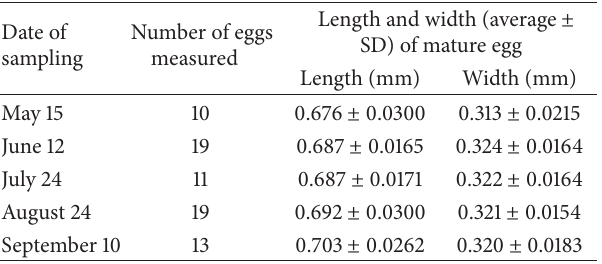
Table 1: Average length and width (mm) of largest mature egg in a female collected in